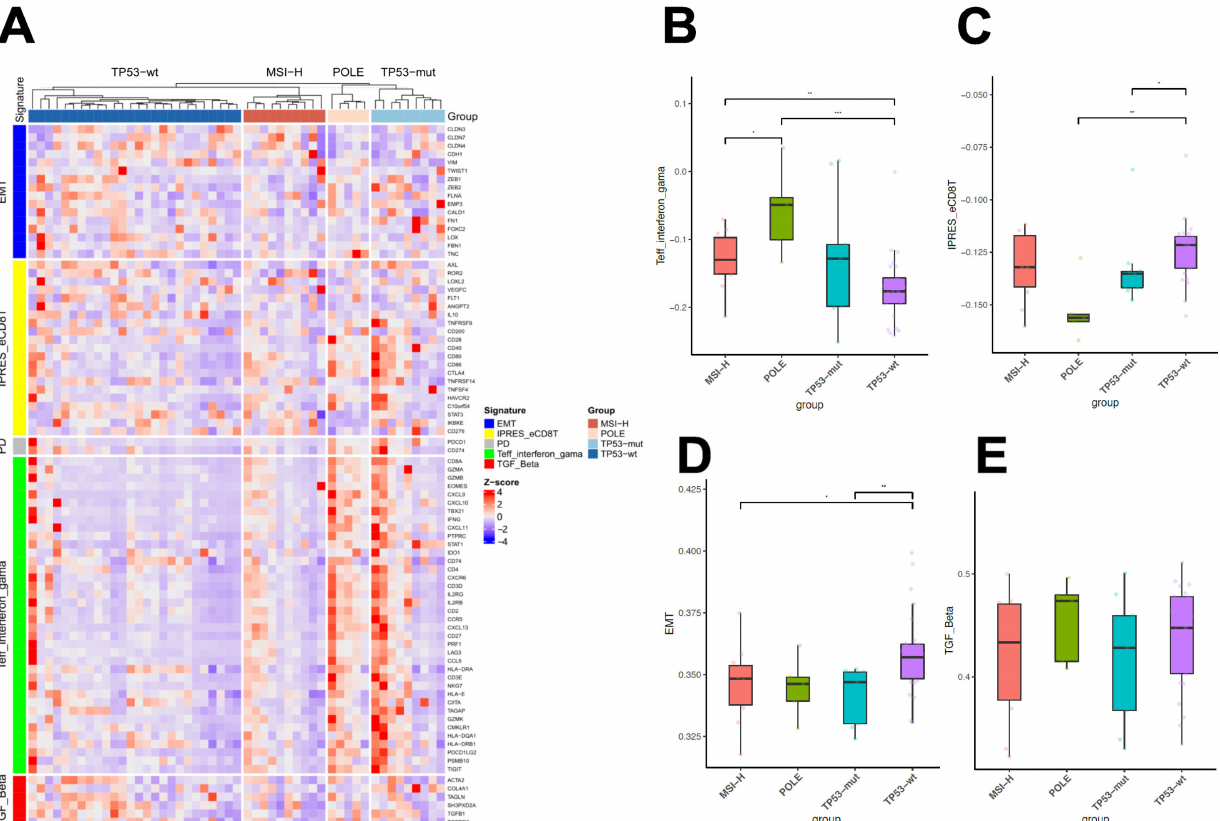
Figure 3. Expression of immunologic genes across four different molecular subtypes of endometrial cancer: ( A ) Heatmap showing expression of 83 T-cell inflamed genes according to endometrial cancer molecular subtype. Gene-level expression values were computed as transcripts per million (TPM) and were normalized to Z-scores before clustering. Genes were arranged according to signatures; ( B – E ) Comparison of single sample Gene Set Variance Analysis (ssGSVA) scores of gene signatures across subtypes, including signatures of T-effector and interferon-gama (Teff_interferon_gama) ( B ), innate anti-PD-1 resistance and CD8+ T cell exhaustion (IPRES_eCD8T) ( C ), epithelial-mesenchymal transi- tion (EMT) ( D ) and TGF-Beta ( E ). Asterisks denote statistical significance; p < 0.05 (*); p < 0.01 (**); p < 0.005